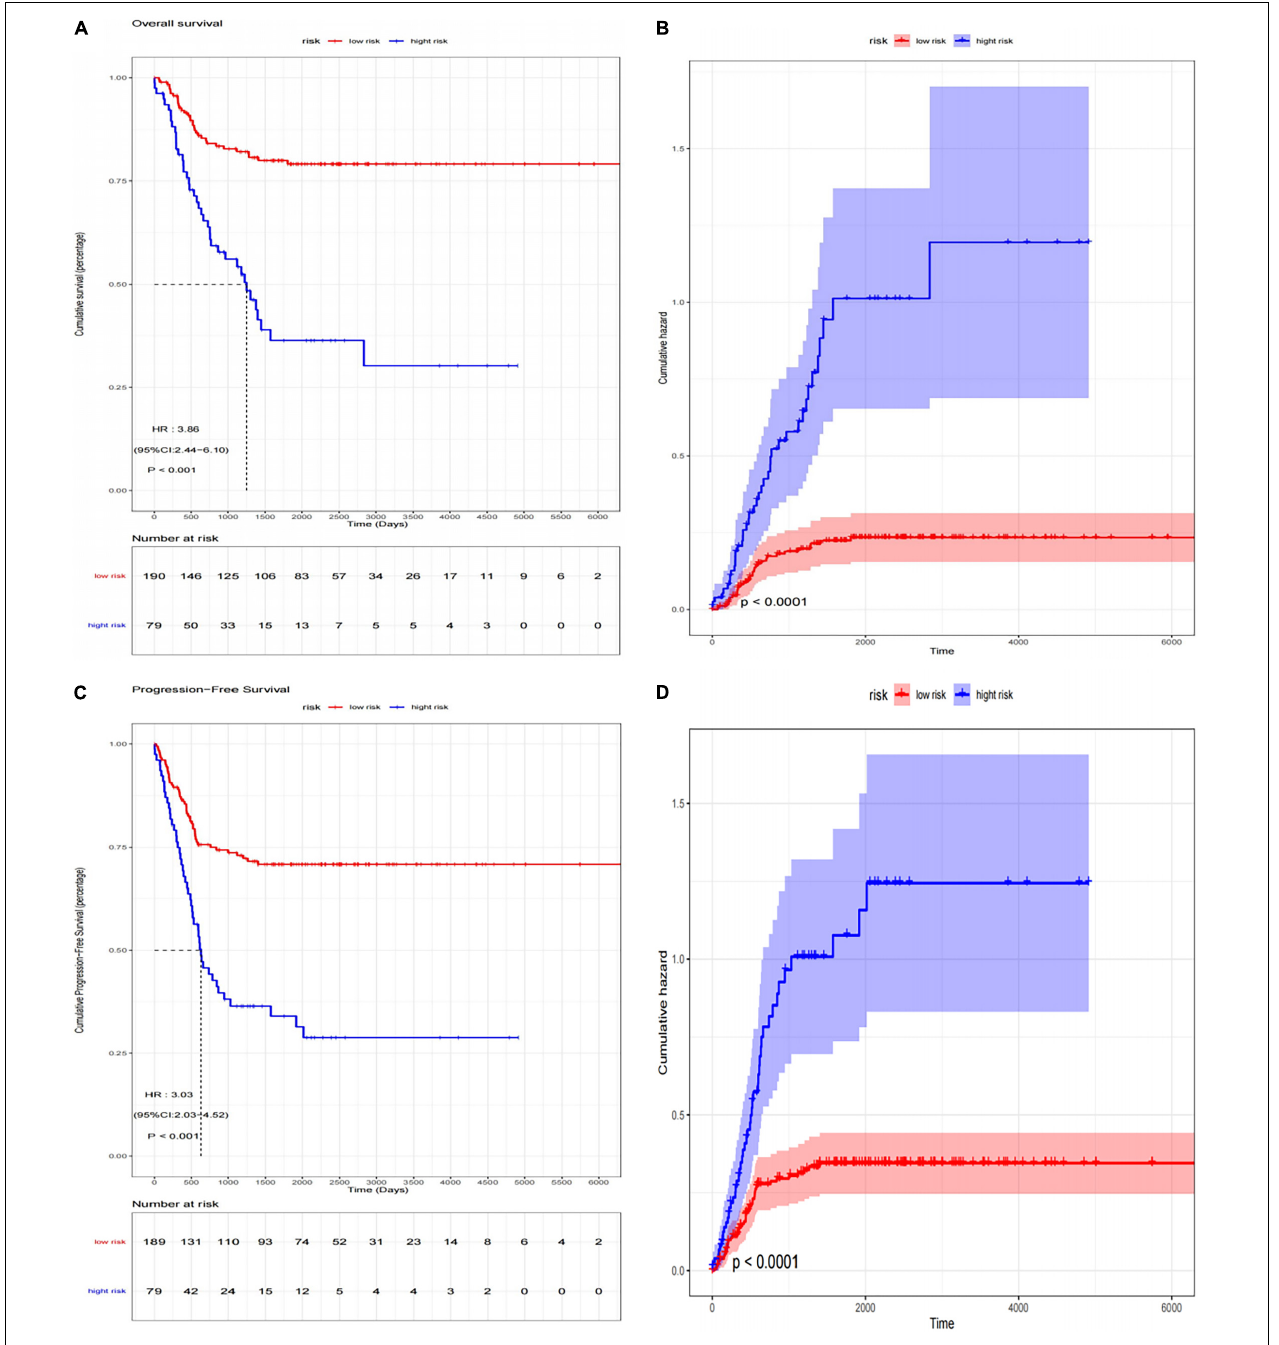
FIGURE 7 | The Kaplan–Meier survival analysis for neuroblastoma patients divided into high-risk subgroup and low-risk subgroup. (A) Kaplan–Meier survival curves (log-rank test, HR: 3.86 (95% CI: 2.44–6.10), p < 0.001) and (B) cumulative risk curves (log-rank test, p < 0.001) of OS for high-risk and low-risk subgroup in validation set; (C) Kaplan–Meier survival curves [log-rank test, HR: 3.03 (95% CI: 2.03–4.52), p < 0.001] and (D) cumulative risk curves (log-rank test, p < 0.001) of PFS for high-risk and low-risk subgroup in validation